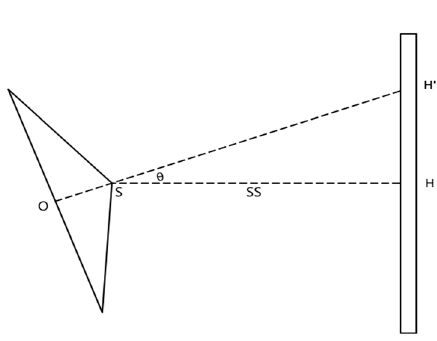
Figure 6. The influencing value from angle θ . O is the image center, S is the projection center, as OS is small enough, H and H′ are the real value and measuring value of the height of the photograph center, respectively.